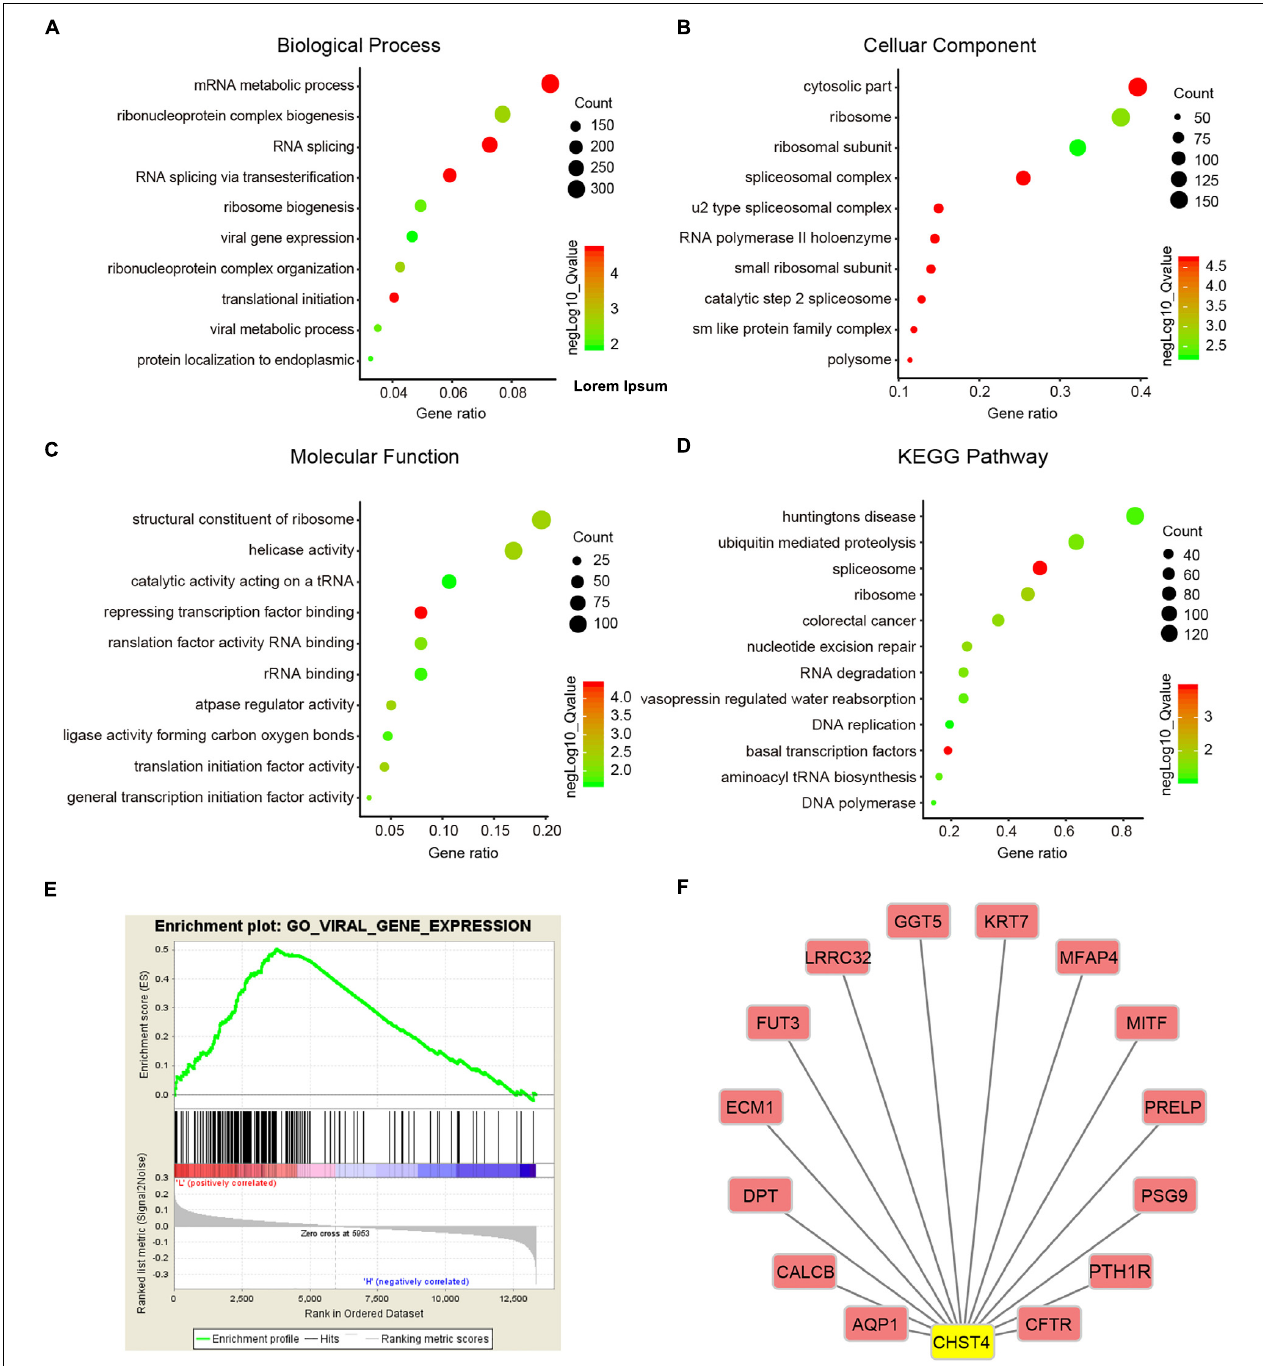
FIGURE 7 | Gene function and downstream pathway analysis for CHST4. (A–D) Gene ontology (GO) analysis of CHST4 for HBV-HCC patients in the GSEA14520 dataset by gene set enrichment analysis (GSEA). (E) Relationship between CHST4 and viral gene expression by GO analysis. (F) The co-expressed genes of CHST4 in